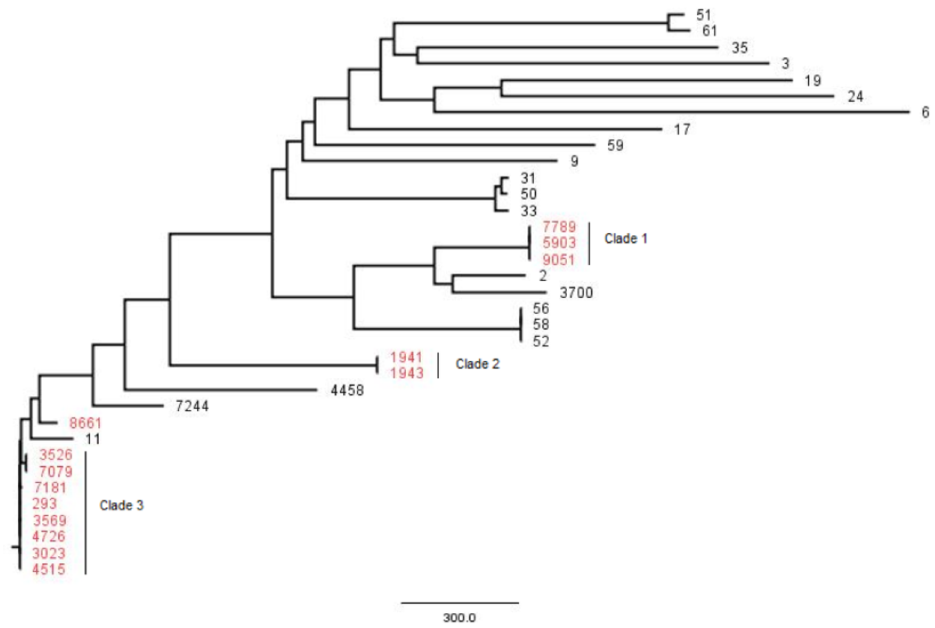
Figure 1. Clustering of the 35 N. gonorrhoeae sequences obtained by WGS, based on genome SNPs; red indicates non-azithromycin-susceptible isolates.